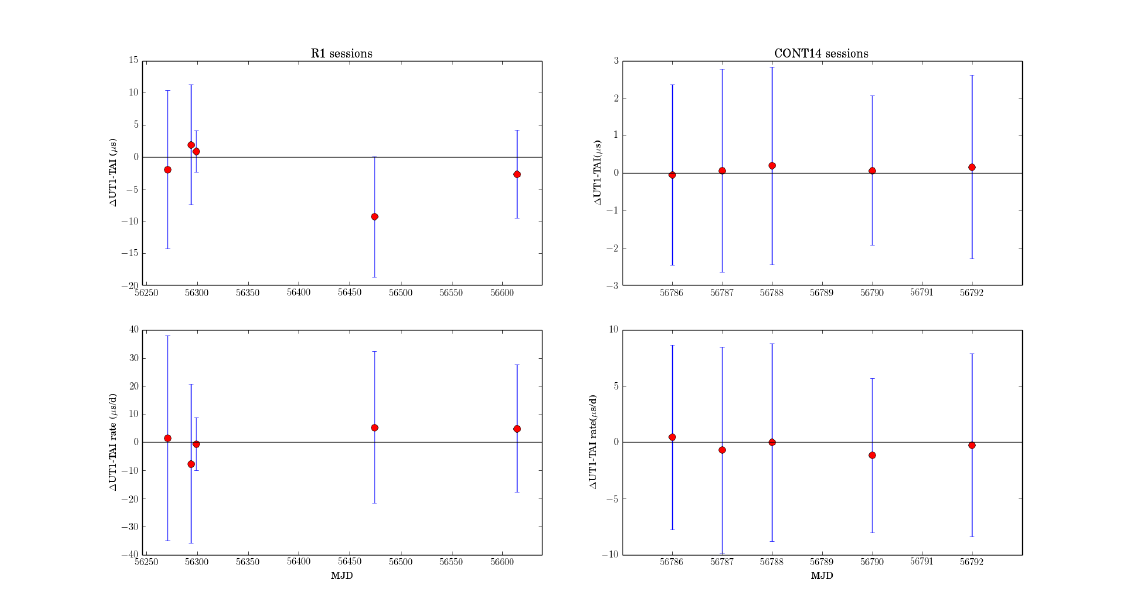
Figure 7: The differences in UT1-TAI (top row) and UT1-TAI rate (bottom row) from IVS-R1 (left column) and CONT14 (right column) sessions, when either On or Od data are used in the